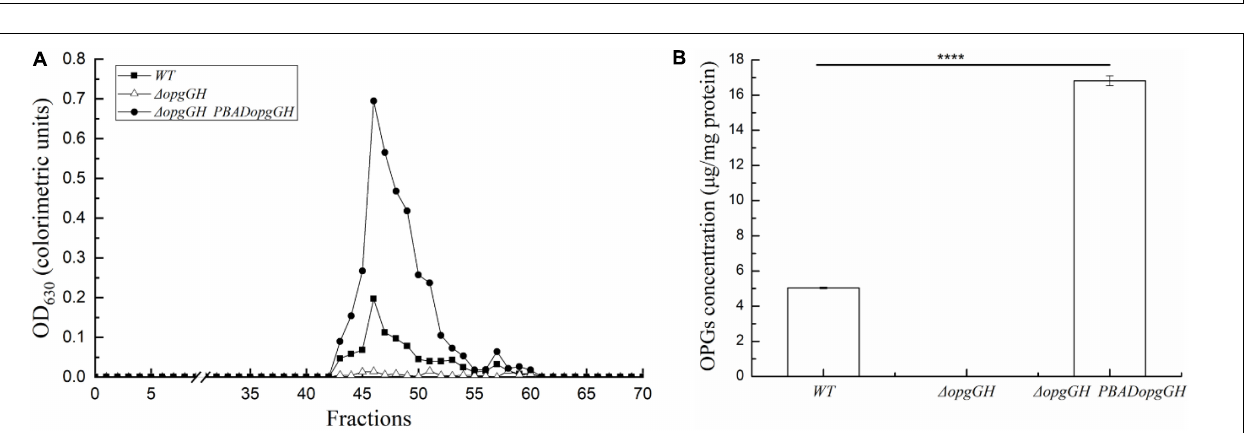
FIGURE 1 | Growth characteristics of the wild-type, (cid:49) opgGH and (cid:49) opgGH -P BAD opgGH strains of Yersinia enterocolitica. Bacteria were grown in LB (A) , LBNS (B) , and LNNS (C) media supplemented with 0.6 g/L L -arabinose. The data are presented as the mean ± SD of at least three independent experiments.